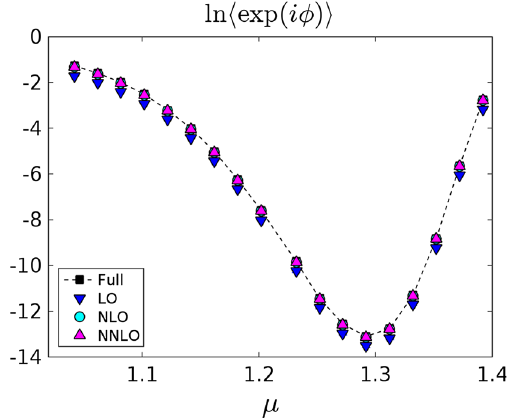
Fig. 9 Comparison of the phase factor expectation value, computed with the “full theory”, with the result from the advanced moments method. We observe that the moment expansion rapidly converges with the NNLO and NNLO lie on top of each other and are indistinguishable from the full answer. Statistical error bars are included